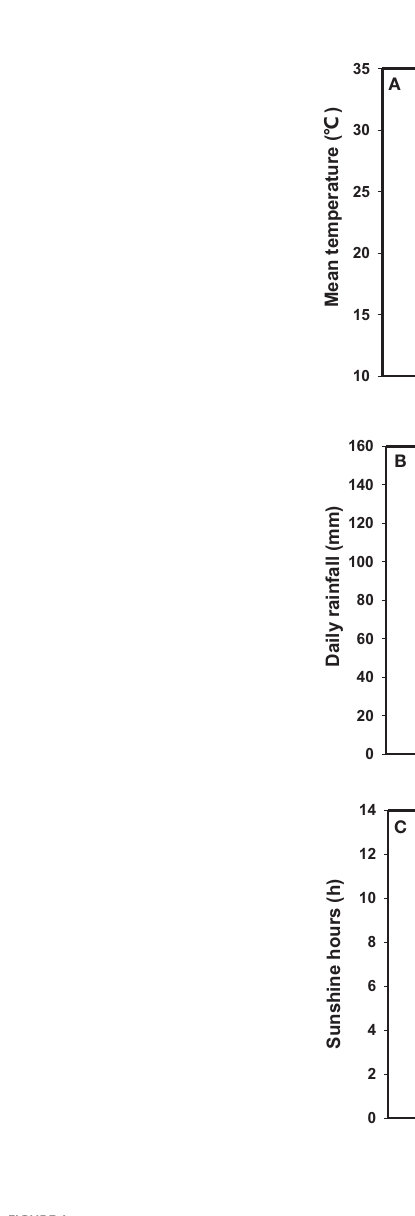
FIGURE 1 Daily mean temperature (A) , daily rainfall (B) and daily sunshine hours (C) in 2020 and 2021 during growth periods (from May to October) at experiment site of Dafeng